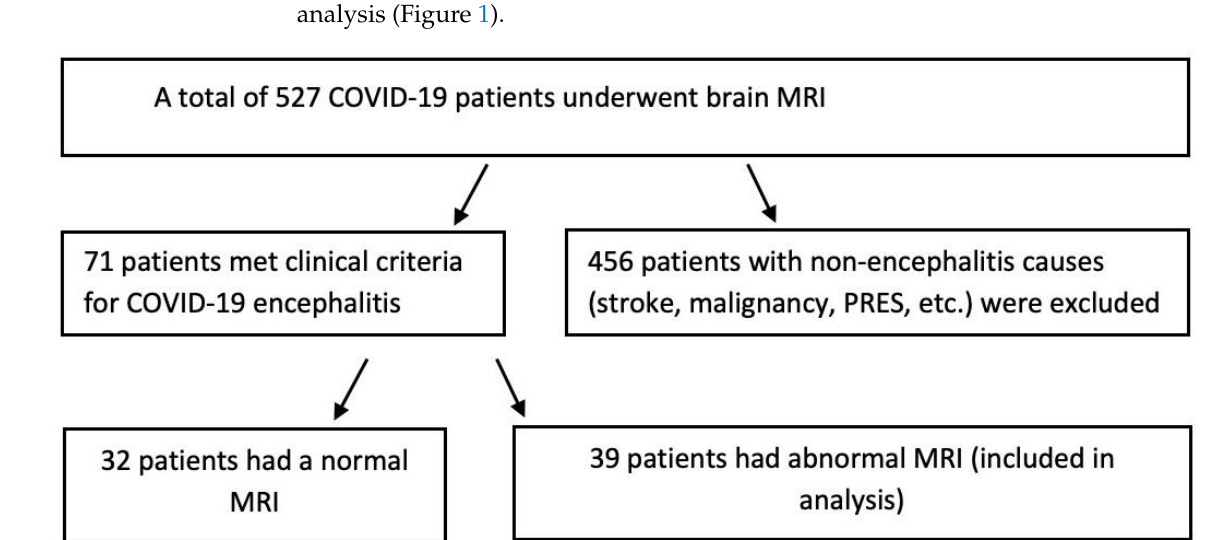
Figure 1. Patient enrollment flow chart.